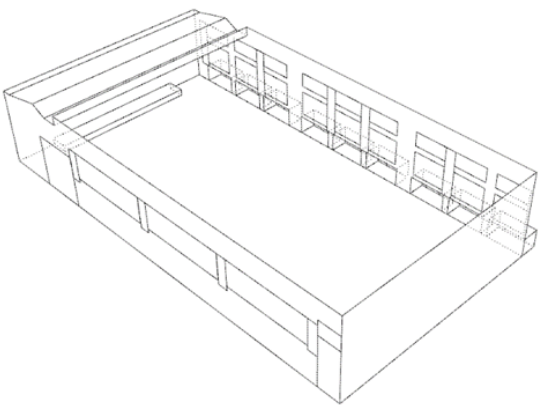
Figure 14. 3D model for simulation. Table 7. Absorption coefficient settings in simulation.